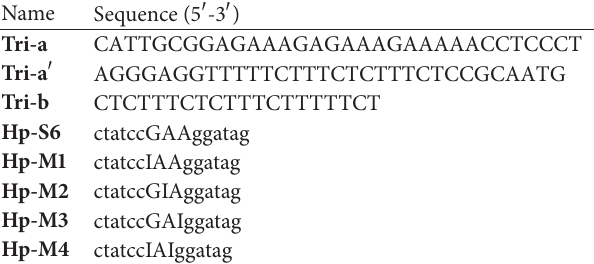
Table 2: Sequences of DNA triplex and hairpins used in this